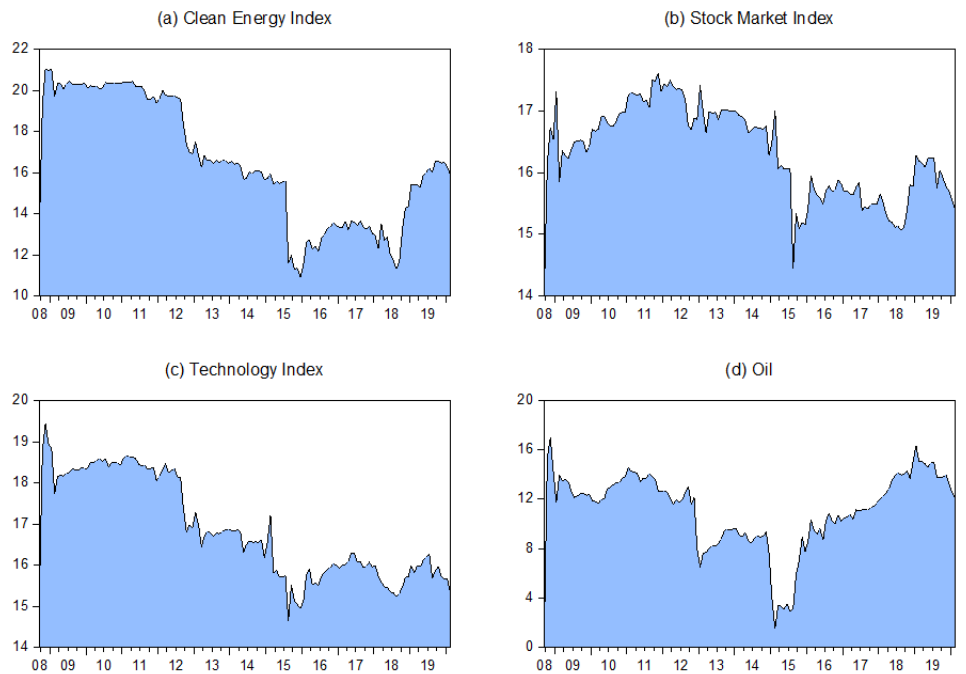
Figure 4. Directional spillovers FROM among the clean energy (CE), S&P 500 (ST), technology (TE), and crude oil (WTI) series. Note: The x -axis indicates the time and the y -axis shows the percentage change in the directional spillover